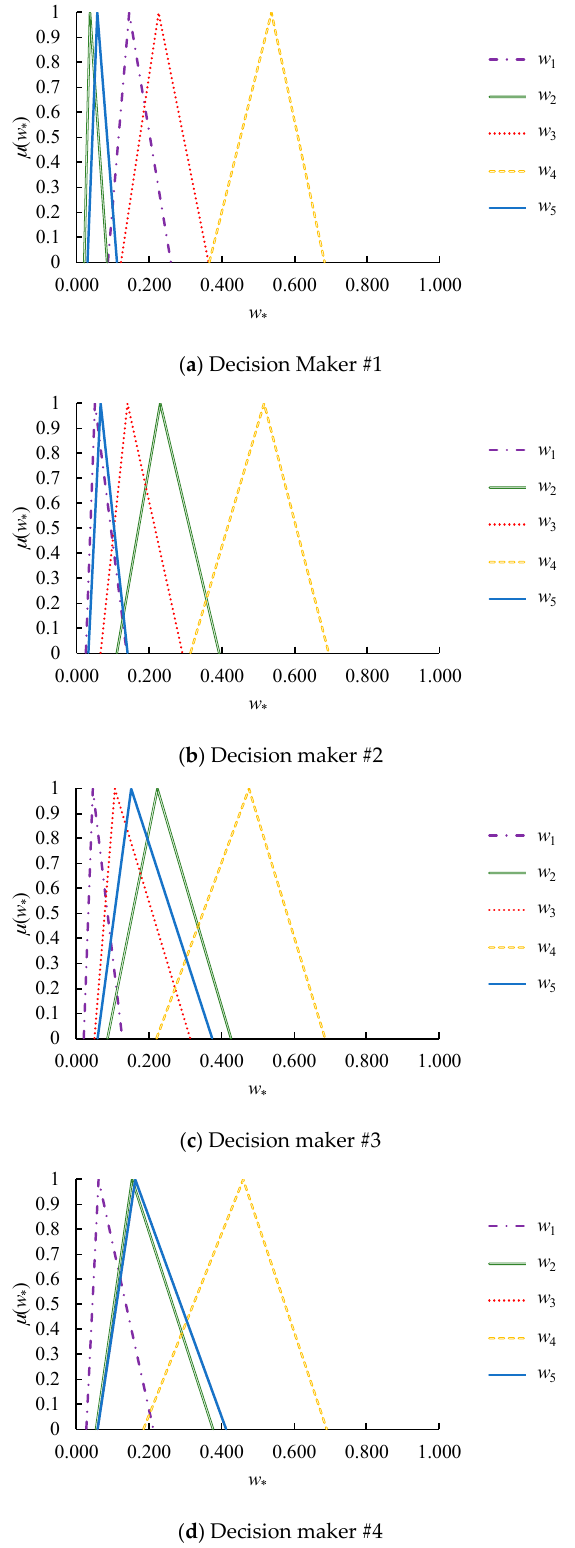
Figure 7. The derived relative priorities.